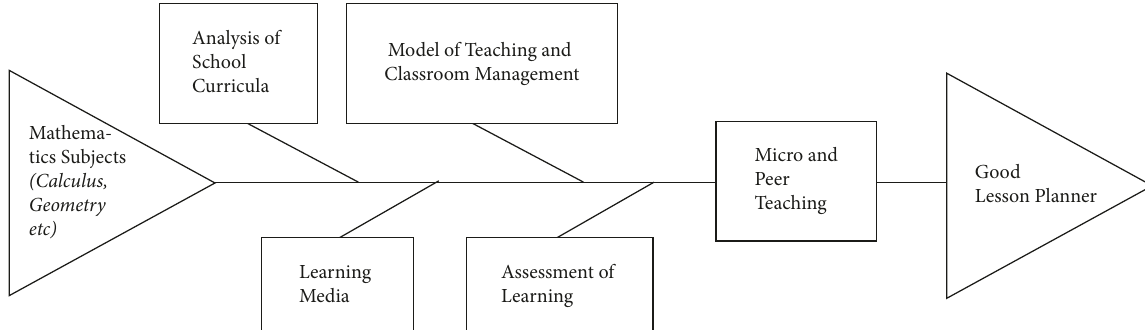
Figure 1: Fishbone diagram of subjects that prospective teachers must pass to become good lesson